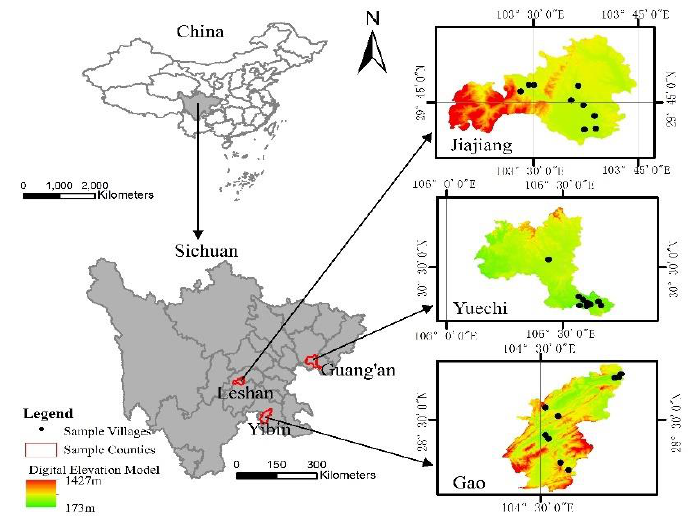
Figure 2. Location map of sample counties and towns.